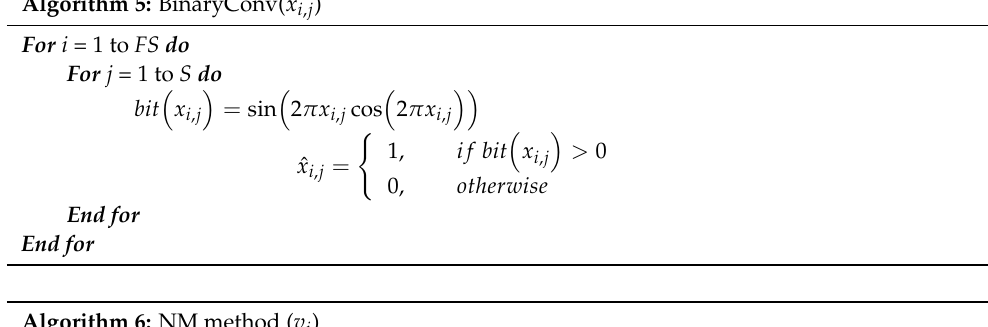
Algorithm 6: NM method ( v i